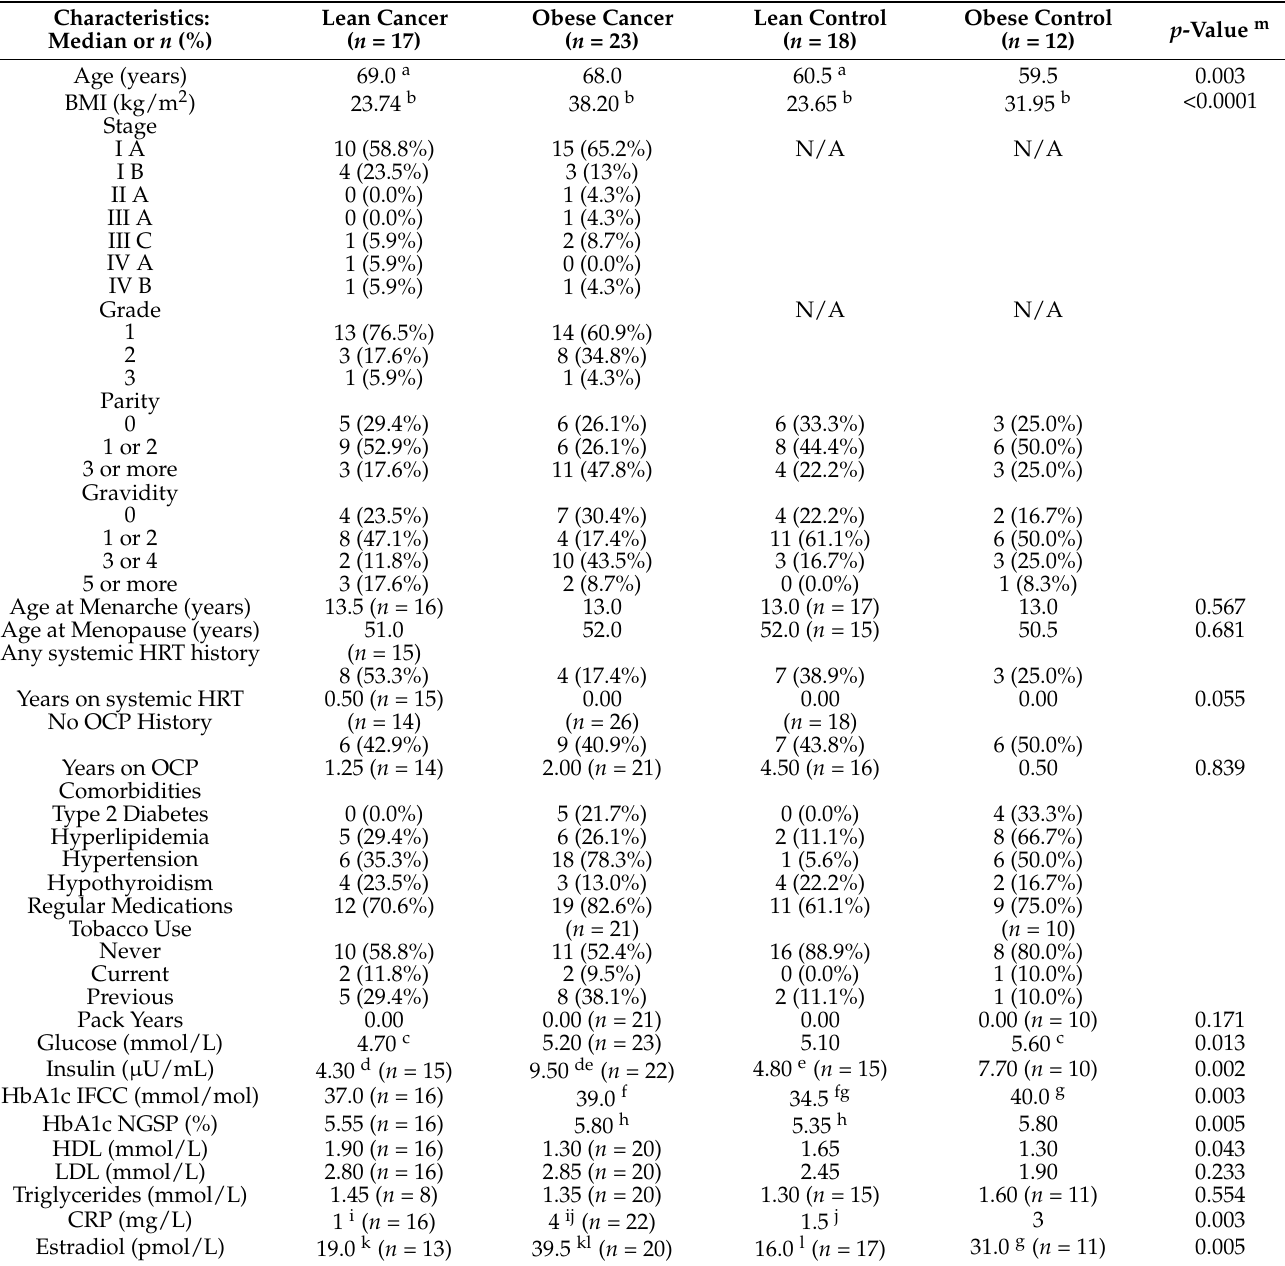
Table 1. Baseline characteristics and metabolic parameters of